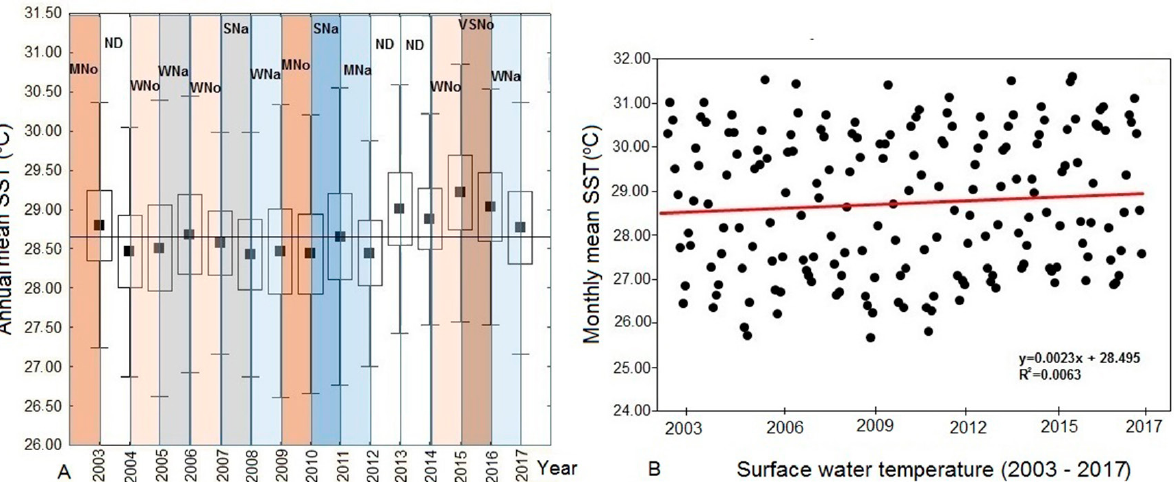
Fig. 3. – Annual mean SST (A) and SST tendency (B) for the 2003-2017 period. A. The horizontal black line shows annual mean value and coloured vertical bars show incidence of El Niño and La Niña events. WNo (Weak Niño); MNo (Moderate Niño); VSNo (Very Strong Niño); WNa (Weak Niña); MNa (Moderate Niña); SNa (Strong Niña); ND (No data). The boxes represent mean±SE and the vertical bars represent mean±SD. B. The red line represents temperature tendency.